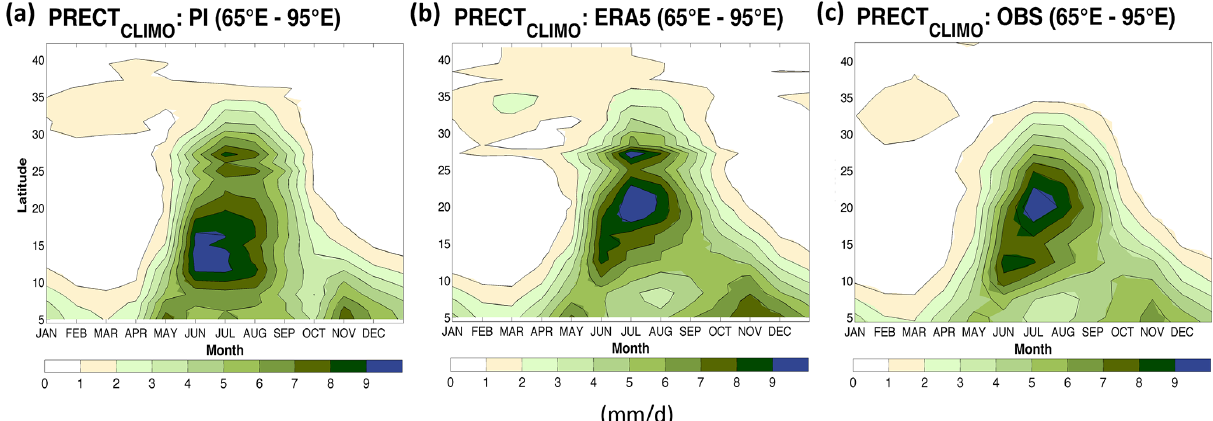
Figure A2. Climatological seasonal cycle of zonal-mean precipitation (PRECT; mm/d) between 65 and 95 ◦ E from (a) the PI simulation, (b) the ERA5 reanalysis for the period 1979–2018, and (c) the Global Precipitation Climatology Project (GPCP) version 2.3 for the period